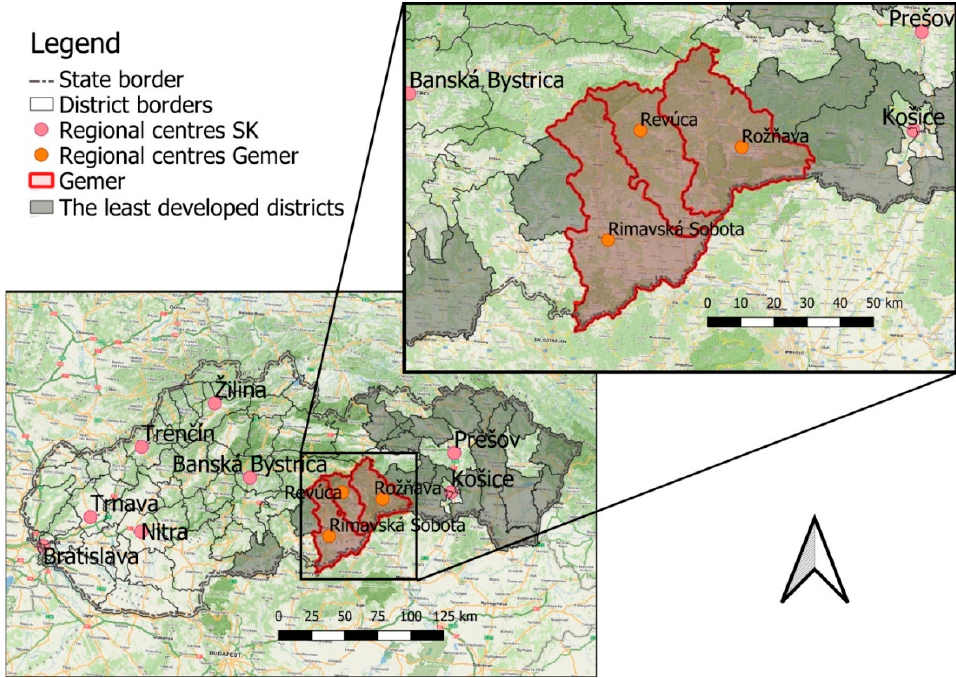
Figure 1. Location of Gemer region within the Slovak Republic.